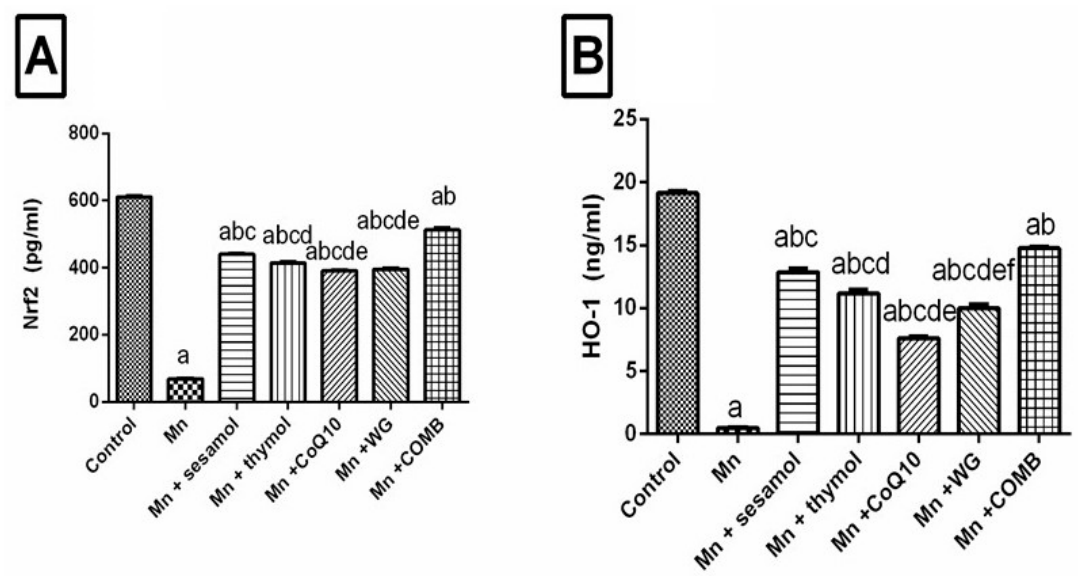
Figure 5. Effects of sesamol, thymol, CoQ10, wheat grass, or their combination on MnCl 2 -induced changes in ( A ) Nuclear Factor Erythroid 2-Related Factor 2 (Nrf2) and ( B ) Hemoxygenase-1 (HO-1). Values are means of 6 rats ± S.E.M, as compared with control (a), Mn (b), COMB (c), sesamol (d), thymol (e), and CoQ10 (f) groups. One-way ANOVA with posttest Tukey’s multiple comparison assessed the statistical differences between the various groups, p -value < 0.05. Table 3. Effect of sesamol, thymol, CoQ10, WG, or their combination on MnCl 2 -induced changes in brain redox status.